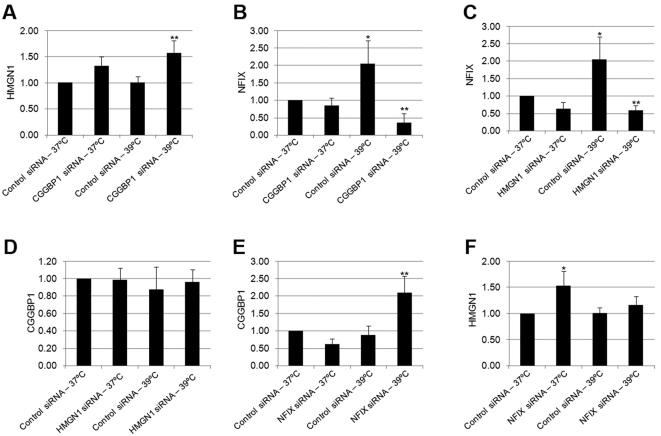
Dynamics of NFIX, CGGBP1 and HMGN1 occupancies at the HSF1 promoter in U-2987 MG cells.HMGN1 occupancy is increased by CGGBP1-siRNA at 39°C (A). NFIX occupancy is increased by heat shock alone and reduced by CGGBP1-siRNA at 39°C (B). Effect of HMGN1-siRNA on NFIX occupancy mimics the effects of CGGBP1-siRNA (C). HMGN1-siRNA or heat shock does not affect CGGBP1 occupancy (D). Loss of NFIX at 39°C increases CGGBP1 occupancy (E). Loss of NFIX at 37°C increases HMGN1 occupancy (F). Single asterisks indicate significant change (p<0.05) compared to respective control-37°C samples. Double asterisks indicate additional significance of change due to heat shock compared to the respective samples at 37°C. The protein assayed in ChIP is shown besides Y-axis and the different siRNA-temperature combinations are indicated along the X-axis. All values are average ±S.D. of ratios calculated by delta-delta Ct method using the input DNA for each sample as internal control with control-siRNA-37°C values as denominators. For control-siRNA-37°C the value is this normalized to 1 in each case, so no S.D. is shown.